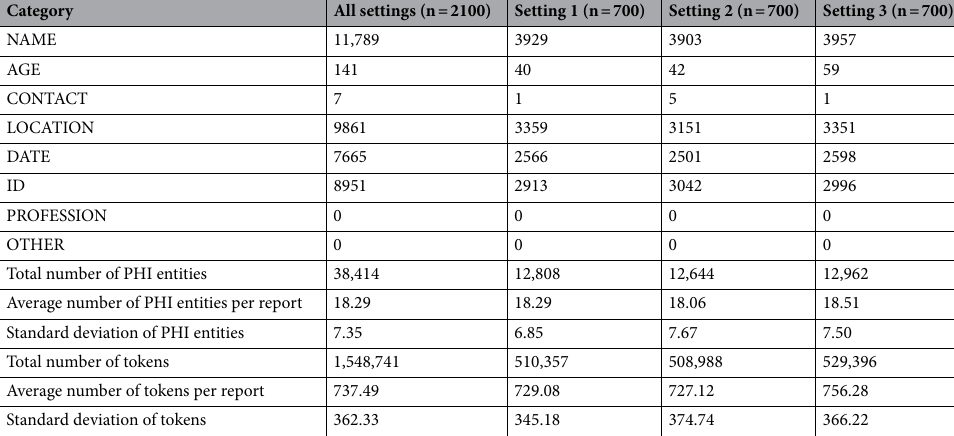
Table 1. Summary of the OpenDeID corpus where n = total number of pathology